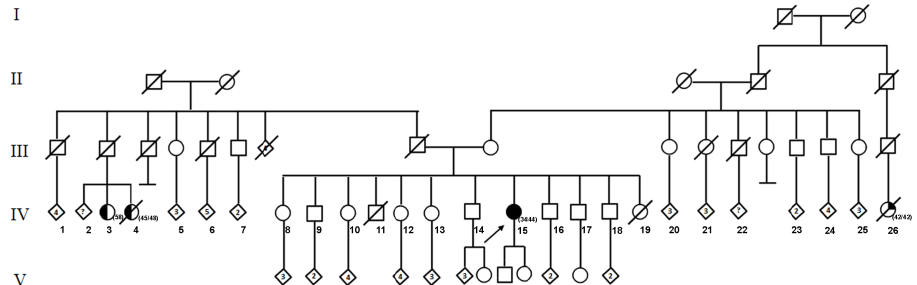
Figure 1. Pedigree of the family of patient suspected of hereditary cancer. The proband IV-15 is indicated by the arrow. The individuals IV-3 and IV-4 were diagnosed with unilateral breast cancer and the individual IV-26 with an unspecified cancer. The age of diagnosis and the current age of affected individuals is given in